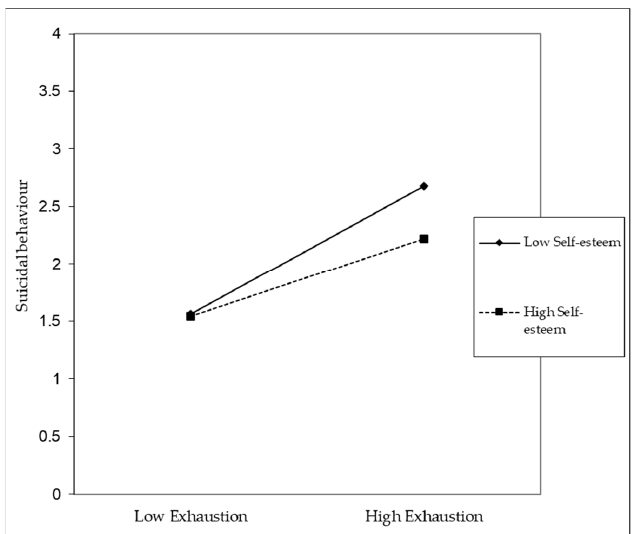
Figure 8. Effect of interaction exhaustion × self-esteem (B = − 0.11; p < 0.001) .